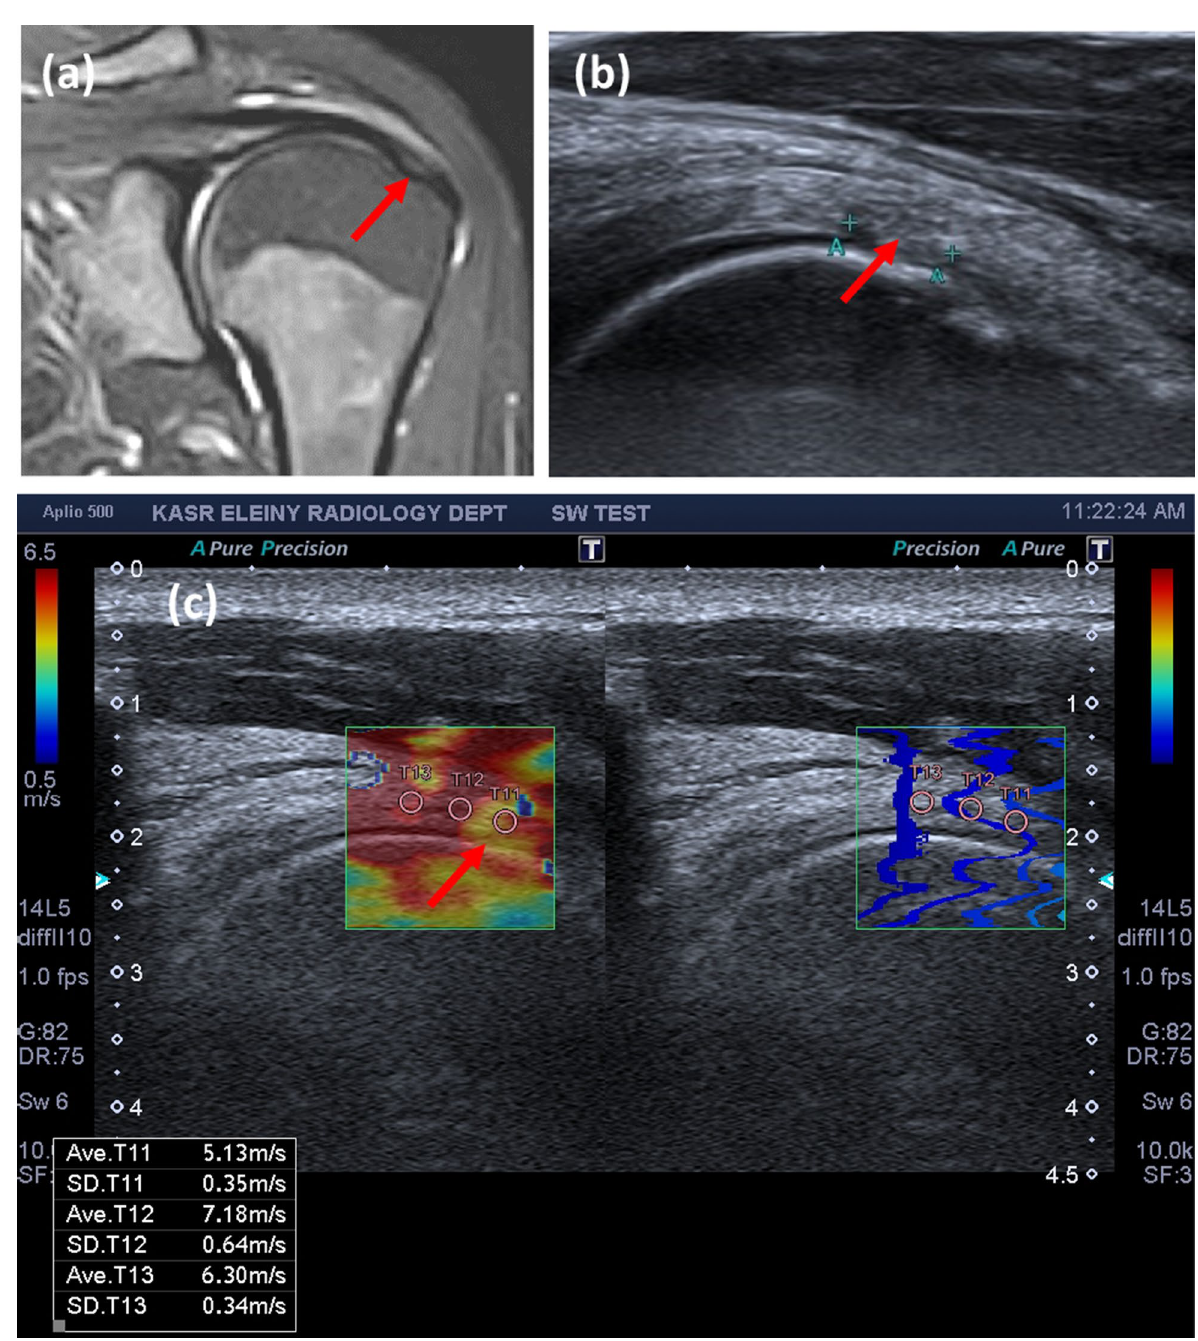
Fig. 5 a MRI coronal oblique STIR images of supraspinatus tendon with small focal area of high signal near the humeral insertion (grade I) corresponding to focal area of reduced echogenicity on B-mode ultrasound ( b ) and mild focal tendon softening on SWE with the corresponding SWV equal to 5.1 m/s ( c